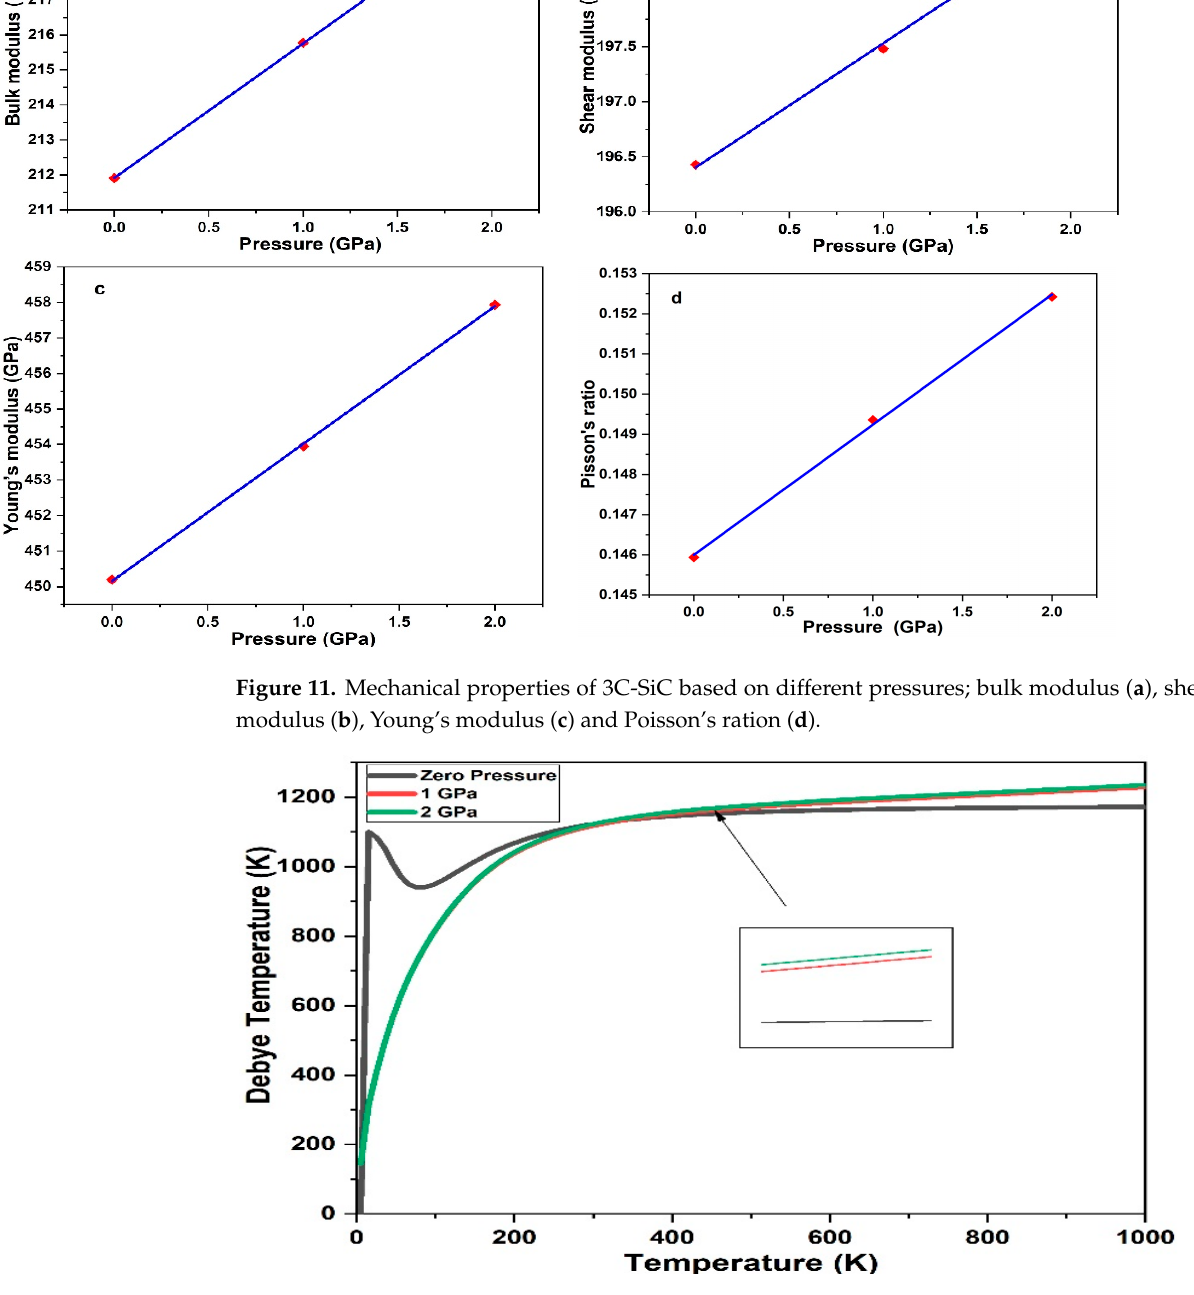
Figure 12. Debye temperature 3C-SiC. Based on Debye quasi-harmonic approximation, we calculated the enthalpy, free en- ergy, entropy, and heat capacity of 3C-SiC with different pressure 0 GPa, 1 GPa and 2